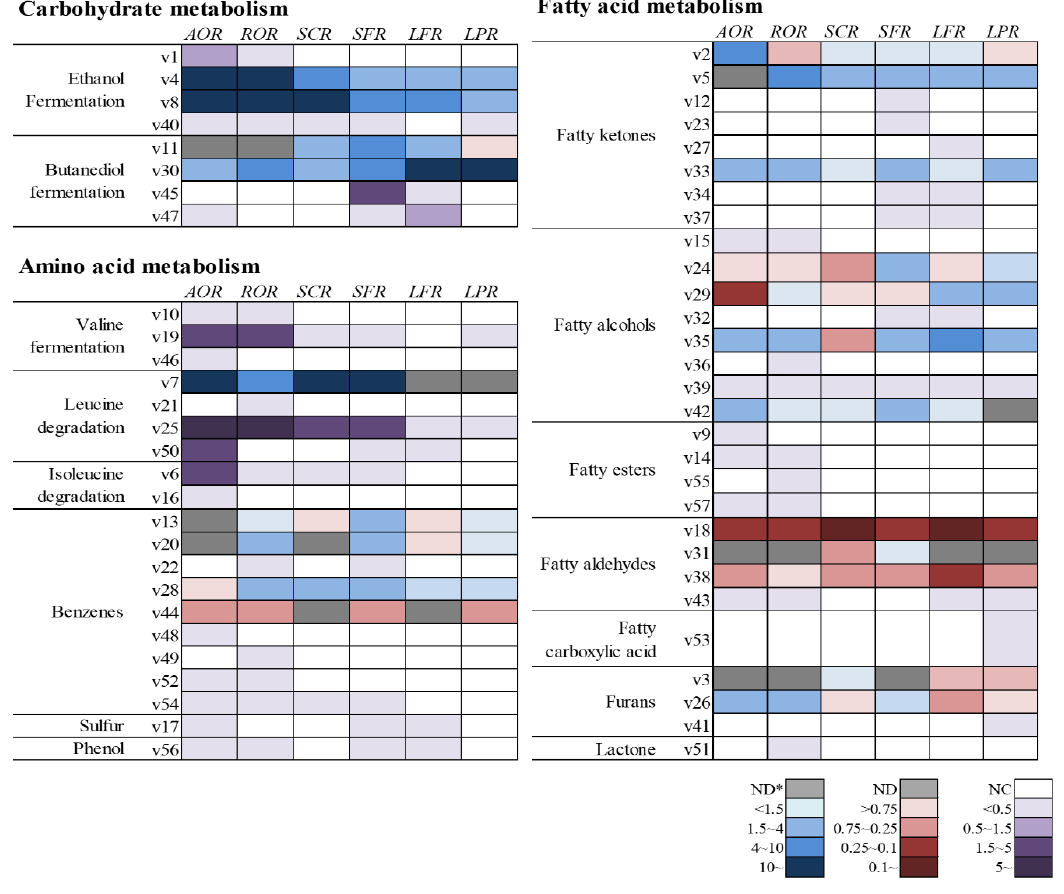
Figure 2. Metabolic pathway-based volatile compound expressions of fermented rice. The fold change of each volatile compound was calculated by comparing to control (RICE): ND; not detected, NC; not changed. Each square represents the fold change (log 2 level) against the control based on the color gradient as shown in the legend (blue; positive, red; negative, and gray; not detected). The formation of volatile compounds which were not detected in the control but were newly produced during fermentation were marked separately (purple; newly detected, white; not detected). Sample abbreviations are shown below; AOR (fermented by Aspergillus oryzae ), ROR ( Rhyzopus oryzae ), SCR ( Sacharomyces cerevisiae ), SFR ( Saccharomycopsis fibuligera ), LFR ( Lactobacillus fermentum ), LPR ( Lactobacillus plantarum ), and RICE (non-fermented rice).